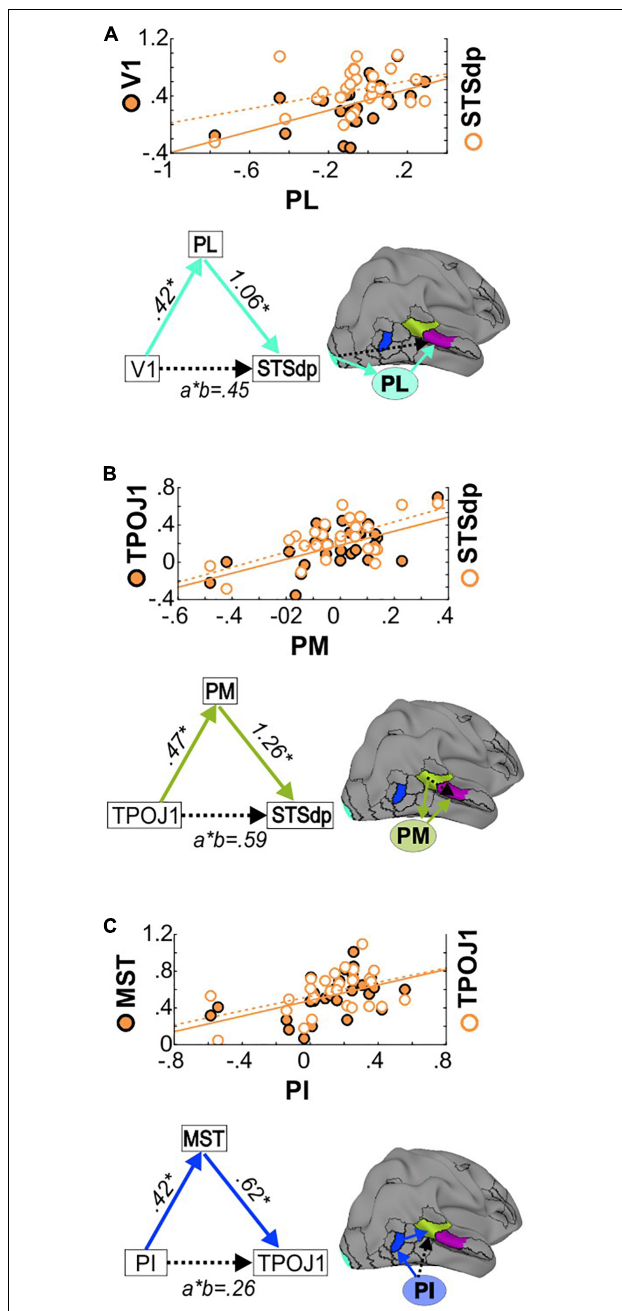
FIGURE 6 | (A) (Top) Correlations between PL and V1 activation (left Y-axis, solid circles) and between PL and STSdp activation (right Y-axis, open circles) in SZ patients. (Bottom) Schematic of the proposed V1 → PL → STSdp path. Beta coefficients are given for the direct (a: V1-PL; b: PL-STSdp) and indirect (a*b) paths. (B) Correlations and TPOJ1 → PM → STSdp mediated path. (C) Correlations and PI → MST → TPOJ1